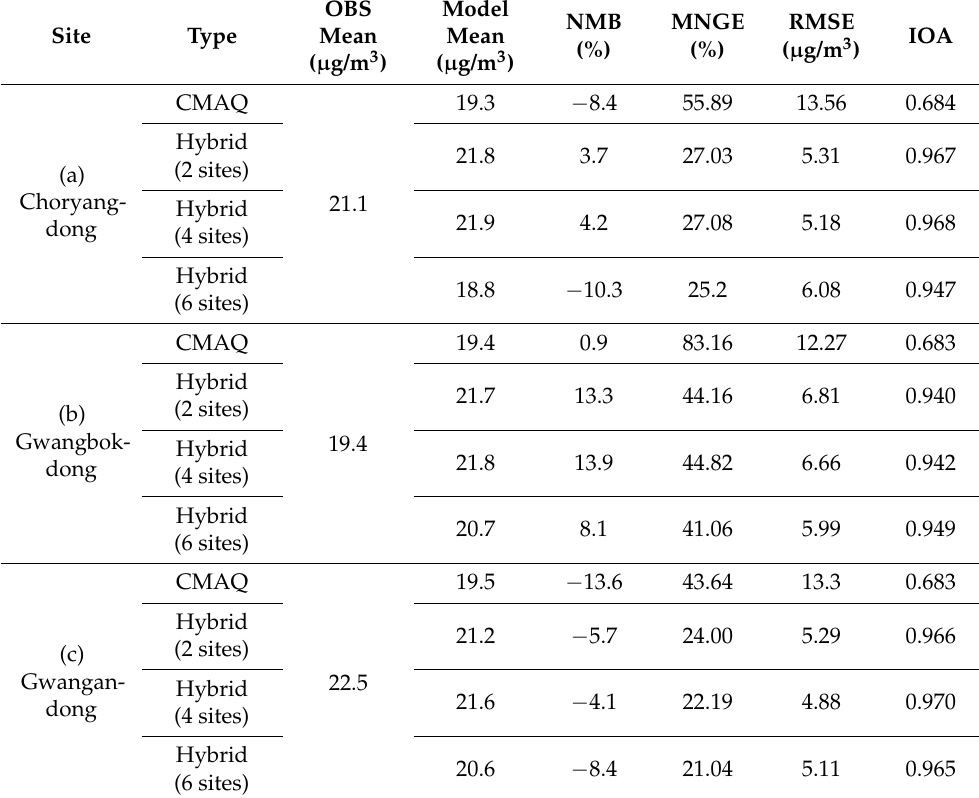
Table 10. Statistics of Hybrid modeled and AQMS-observed PM 2. 5 (OBS: Observations, Model: CMAQ or Hybrid